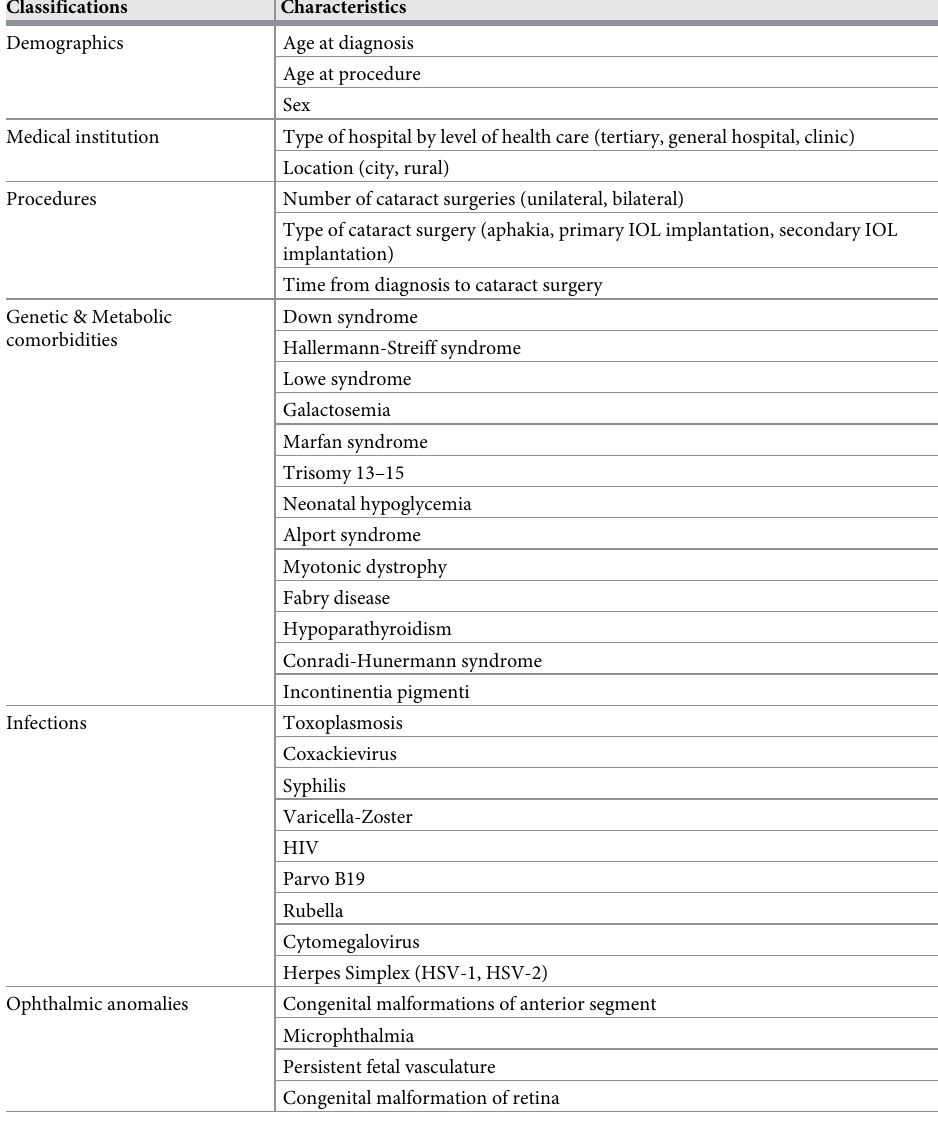
Table 1. Summary of included possible risk factors for post-congenital cataract-surgery